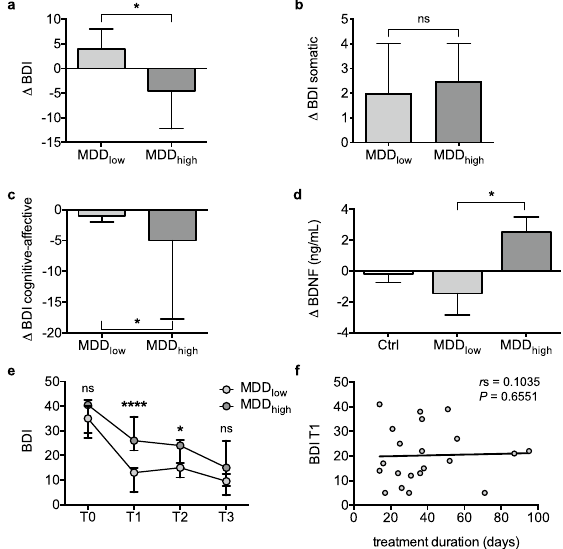
Figure 3. Effect of fasting on BDI-2 scores and BDNF serum levels depends on depression severity pre-fasting. Bar graphs (median with interquartile range) depict the delta of BDI-2 score ( a ), of BDI-2 somatic sub-score ( b ) or BDI-2 cognitive-affective sub-score ( c ) in MDDlow (BDI ≤ 19 at T1) or MDDhigh (BDI > 19 at T1) between post (T2) and pre (T1) fasting values. Change in BDNF values (ΔBDNF, mean with SEM) in Ctrl, MDDlow or MDDhigh are depicted in ( d ). Line chart shows median values and interquartile range of BDI-2 score over the time course of inpatient treatment from the start of inpatient treatment (T0) to the time of discharge (T3) in MDDlow ( N = 10 for T3) and MDDhigh ( N = 9 for T3; e ). Spearman correlation was used to assess association of treatment duration before T1 with BDI-2 values at T1 in the MDD group ( N = 21; f ). Resulting two-tailed P - and r s -values are depicted. Two-tailed P -values comparing change in BDI-2 scores ( a – c ) as well as group differences of BDI-2 score ( e ) were assessed using Mann–Whitney test. One-way ANOVA followed by Tukey’s multiple comparison test was used in ( d ). **** P < .0001, * P < .05. Ctrl: N = 28, MDDlow: N = 11, MDDhigh: N =